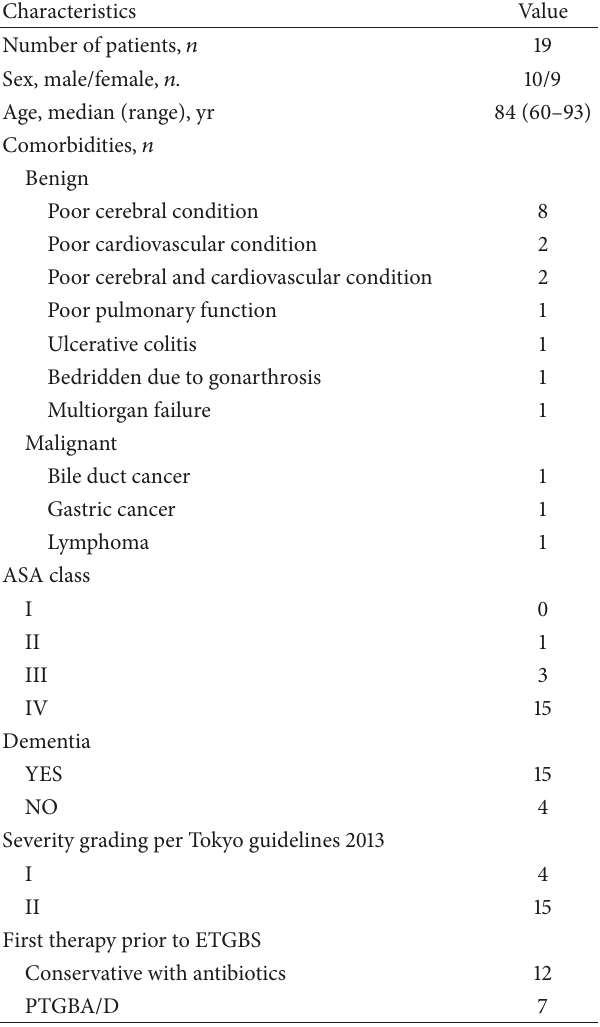
Table 1: Patient